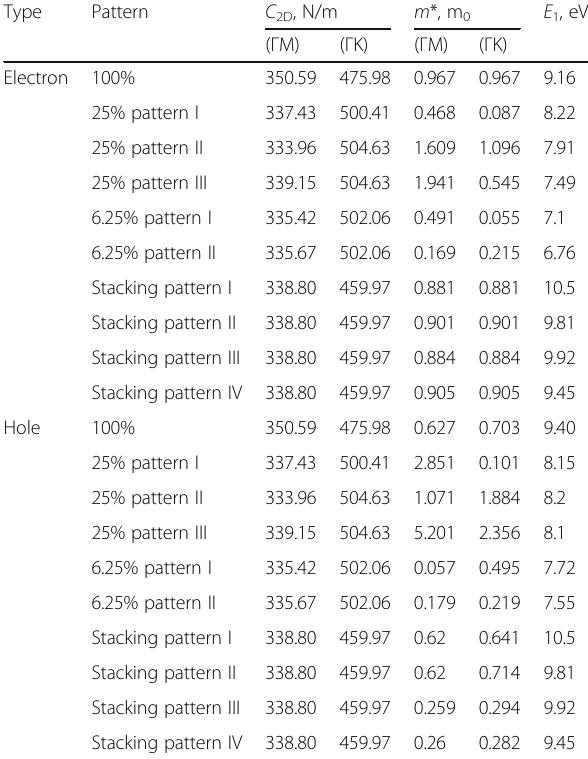
Table 1 The elastic modulus C 2D , effective mass m * , and deformation potential constant E 1 . “ m 0 ” denotes the electron mass 9.109 × 10 − 31 kg